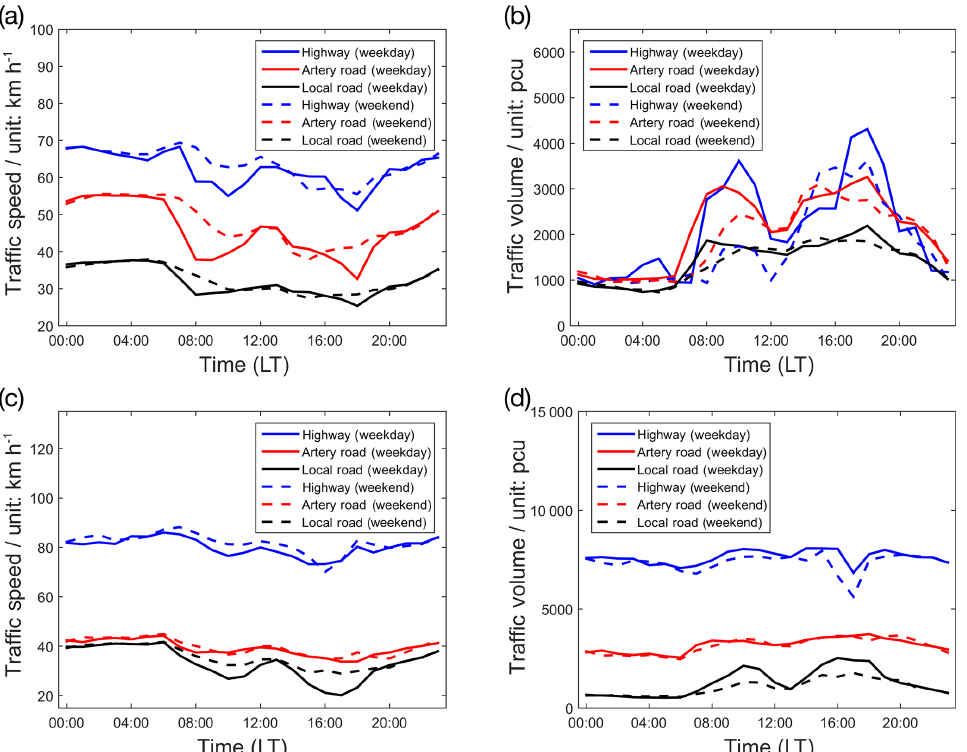
Figure 4. Diurnal variation in average traffic speed and traffic volume in (a, b) urban area and (c, d) suburban area during weekday and weekend.